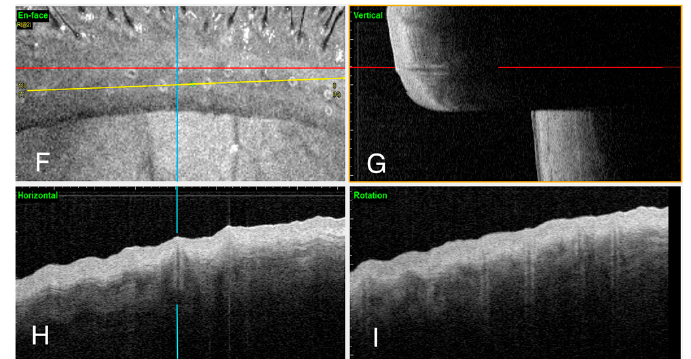
Figure 3. The eyelid margin and meibomian gland openings in normal eyes. Each participant was recorded by obtaining a photo of the upper eyelid margin ( A ), conducting meibography of the upper eyelid ( B ), and then scanning by OCT ( C – I ). During the OCT examination, an infrared picture of the chosen eyelid margin ( C ) was captured. The chosen area (green box in ( C )) could then be transformed into an en-face image ( D ) that clearly showed every orifice (green box in ( D )) in the eyelids. The inner and outer maximal diameter of every chosen meibomian terminal duct connected to the orifice (green box in ( D )) can be measured ( E ). In the en-face image ( F ), three lines can be dragged to show the vertical (blue line ( G )), horizontal (red line ( H )), and rotational (yellow line ( I )) sections. J. Clin. Med. 2020 , 9 , x FOR PEER REVIEW